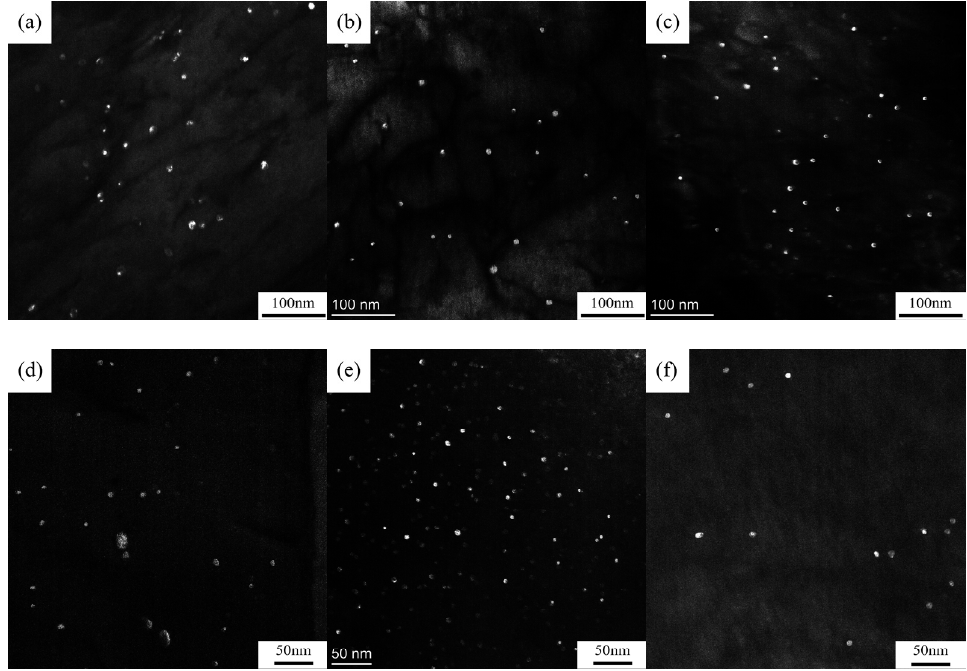
Figure 10. Dark field images of the Al 3 (Sc x Zr 1-x ) ( a ) AA5182 − 0.05Sc − 0.1Zr, 300 °C, 0.01 s − 1 , ( b )